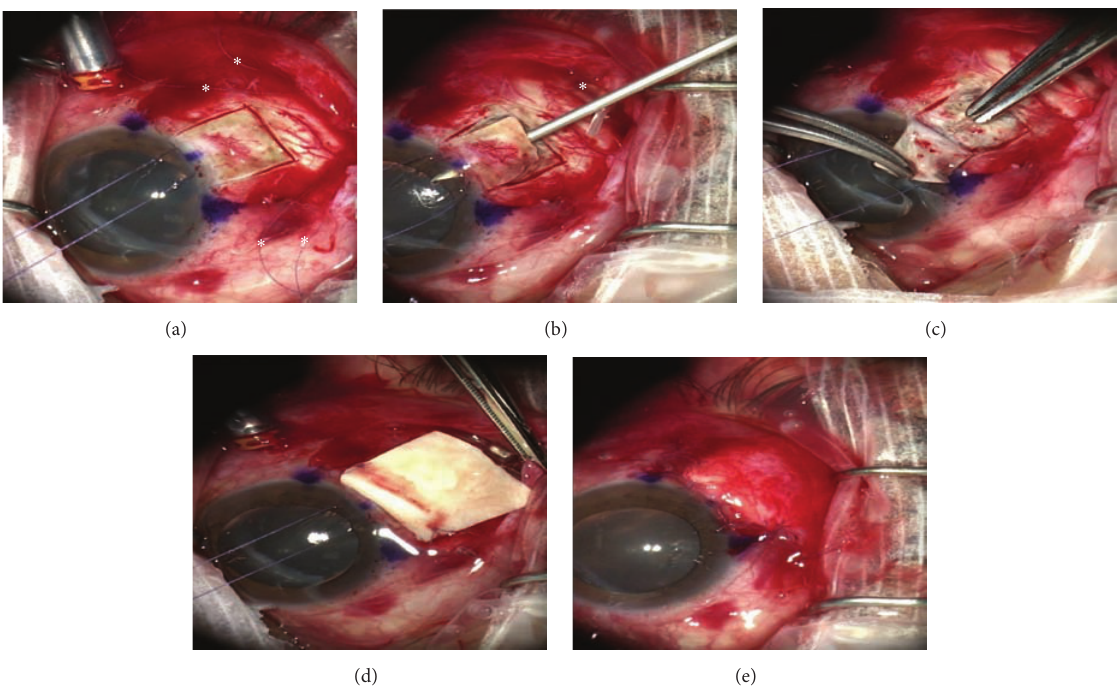
Figure 1: (a) Outline of scleral flap made with crescent blade. Note: 7-0 vicryl limbal retraction suture and marking of 9:00 󸀠 , 10:30 󸀠 , and 12:00 󸀠 positions ( ∗ ). (b) Ahmed Valve sutures in place ( ∗ ) and AC entered and formed with viscoelastic on a 23-gauge needle. (c) Tube cut and inserted into AC, beneath the flap. (d) Human scleral patch graft fixed in place 1-2mm behind limbus 7-0 vicryl suture. (e) Conjunctiva closed with running locking 7-0 vicryl